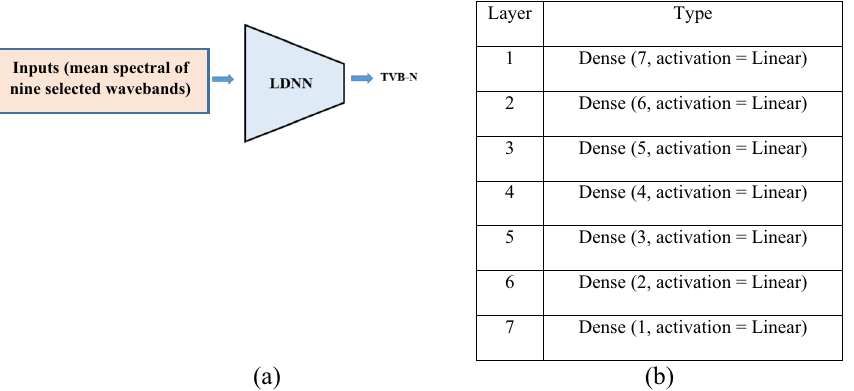
Figure 6. Network structure for first LDNN used in the experiments for regression of TVB-N feature. (a) Schematic diagram, (b) detailed